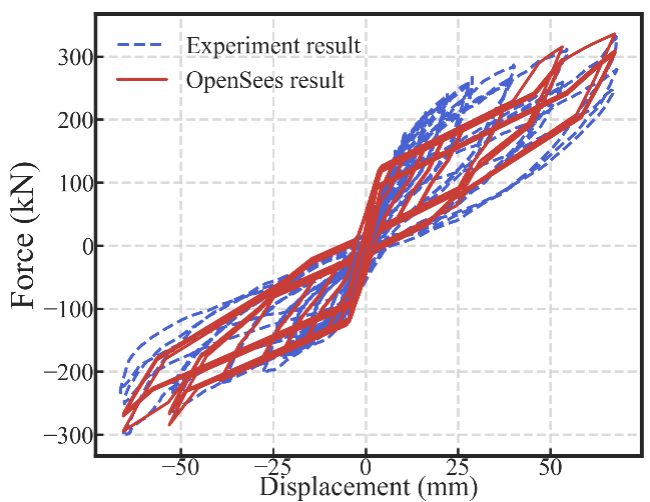
Figure 9. Model validation: the comparison of the hysteretic curves.